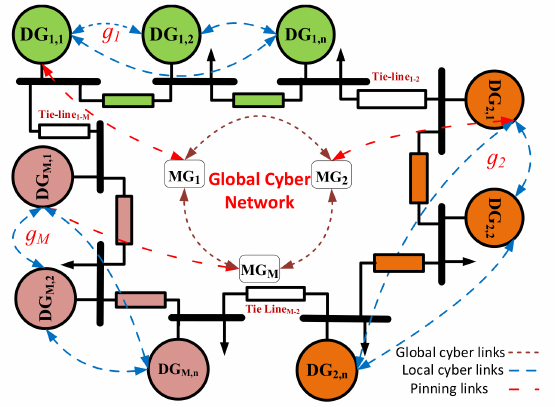
Figure 1. The Single-line diagram for